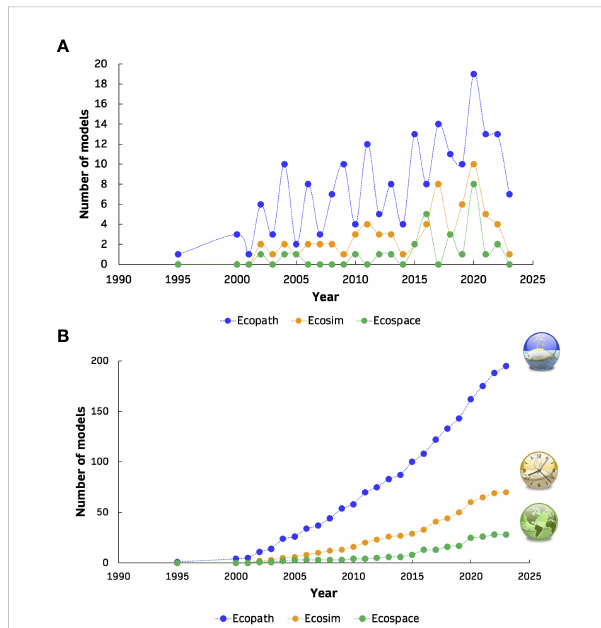
FIGURE 3 Absolute (A) and cumulative (B) annual number of Ecopath (blue), Ecosim (orange) and Ecospace (green) models in peer-reviewed publications and referring to European waters since